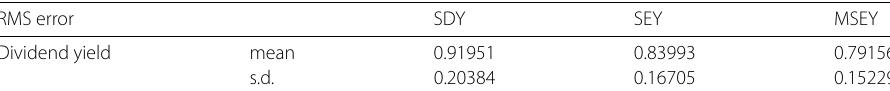
Table 2 Comparison of RMS error RMS error SDY SEY MSEY Dividend yield mean 0.91951 0.83993 0.79156 s.d. 0.20384 0.16705